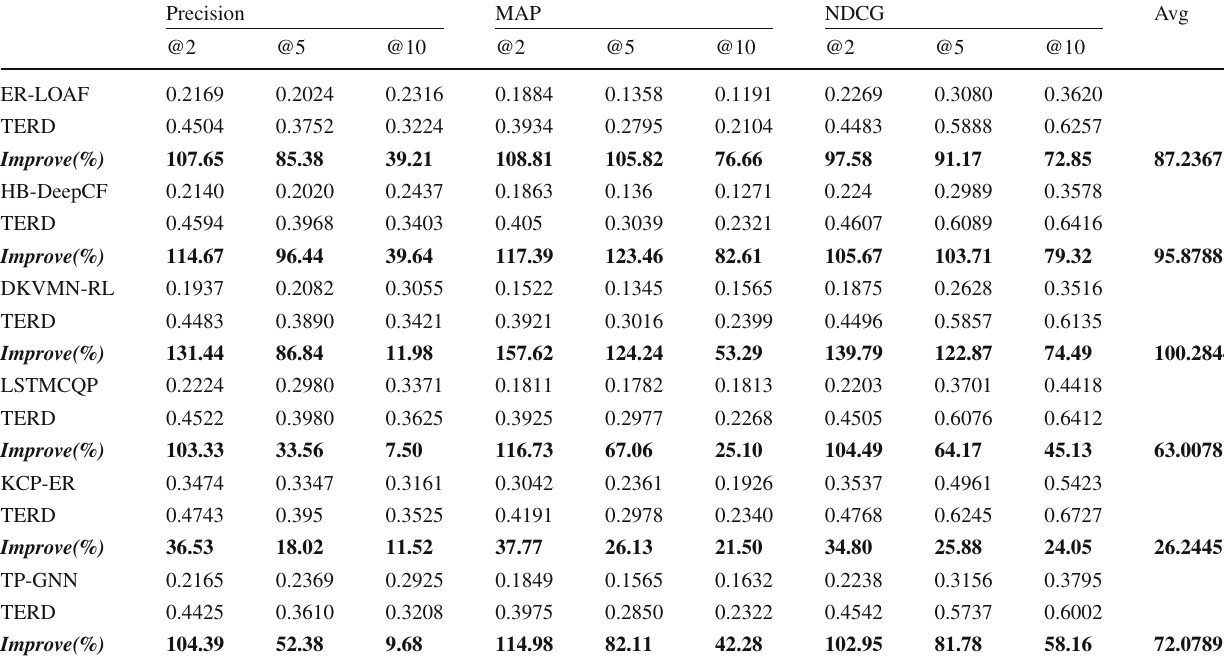
Table 5 Results of comparison among six algorithms with and without adding teacher network on Statics2011 dataset